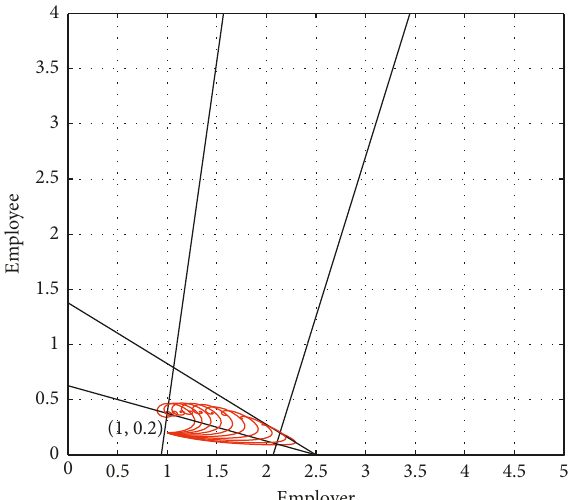
Figure 9: Simulation results with various c ( b